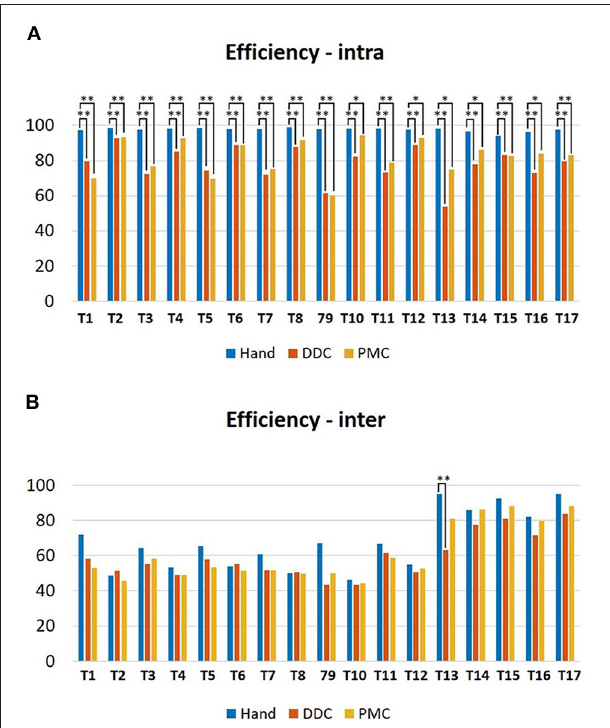
FIGURE 8 | Bar plots showing the median values and the standard deviations upon all the subjects of the (A) intra-subject accuracy and (B) inter-subjects accuracy indices obtained during the execution of the tasks in the three configurations tested. * p < 0.05, ** p < 0.01.